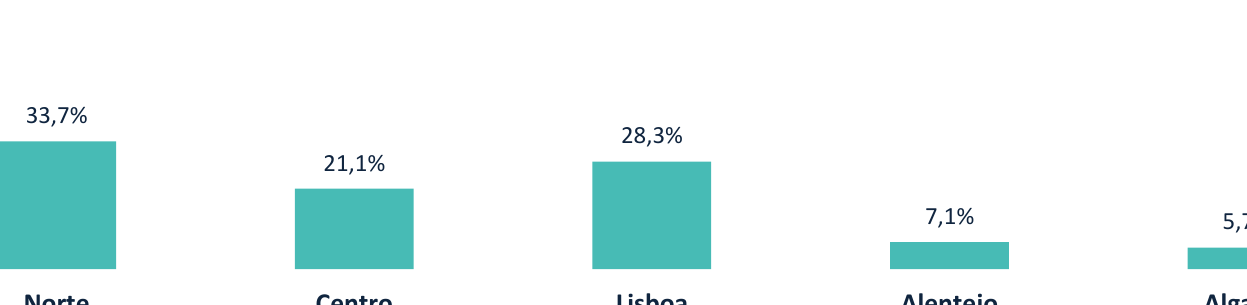
Consumidores empresariais | Base amostral =